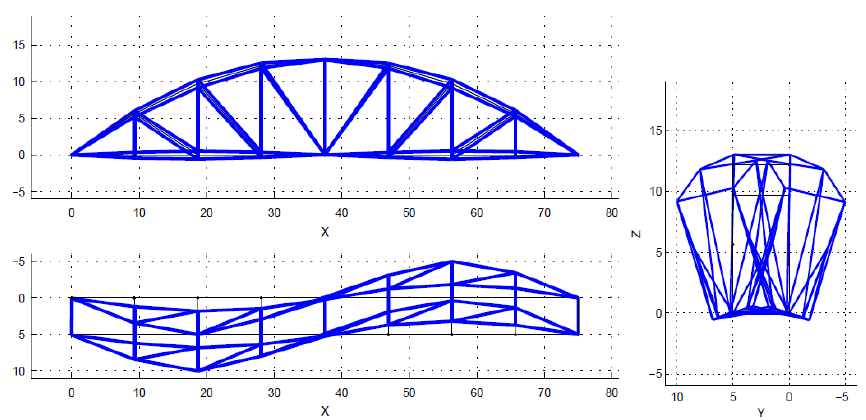
Figure 8. The identified mode 2, first torsion, f = 3.11 Hz, xi = 0.19%.